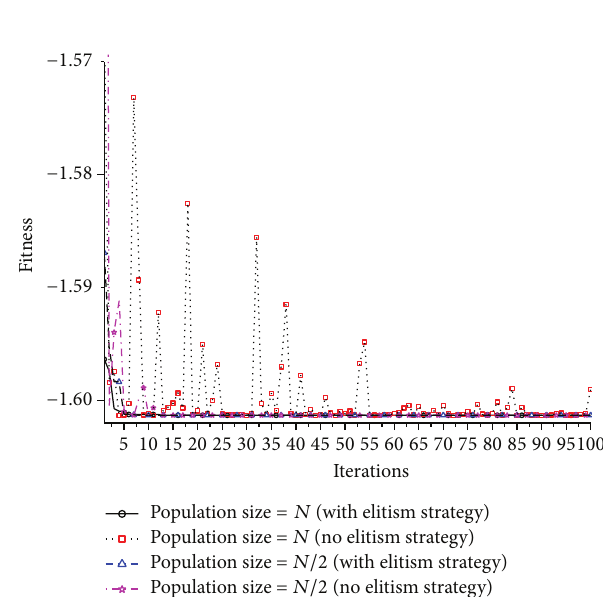
Figure 3: Population operation diagram.